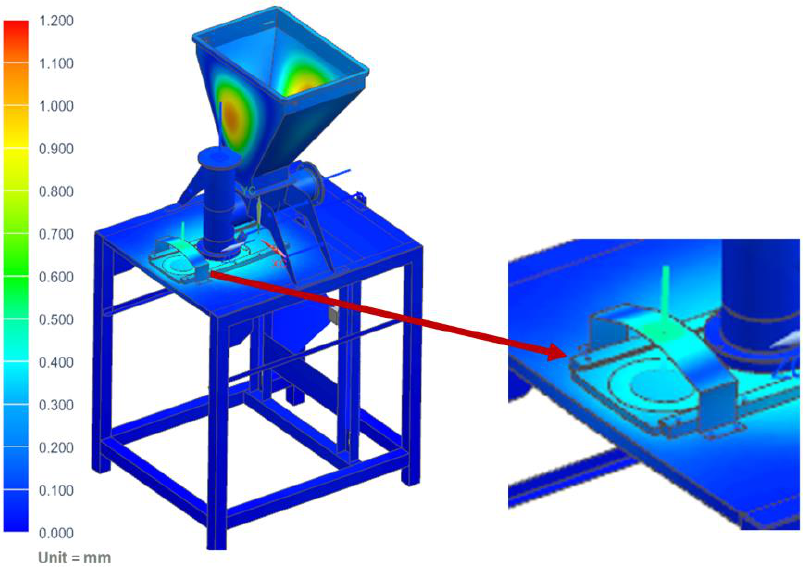
Figure 20. Displacement map of the molding module: ejector collides with the die assembly.